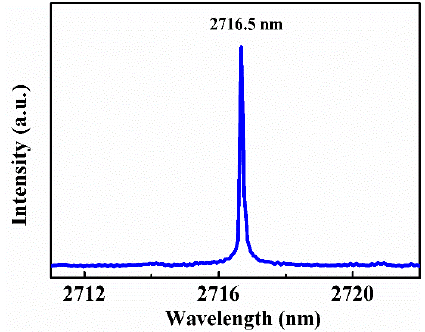
Figure 7. Spectrum of the Q-switched Er:Y 2 O 3 laser.